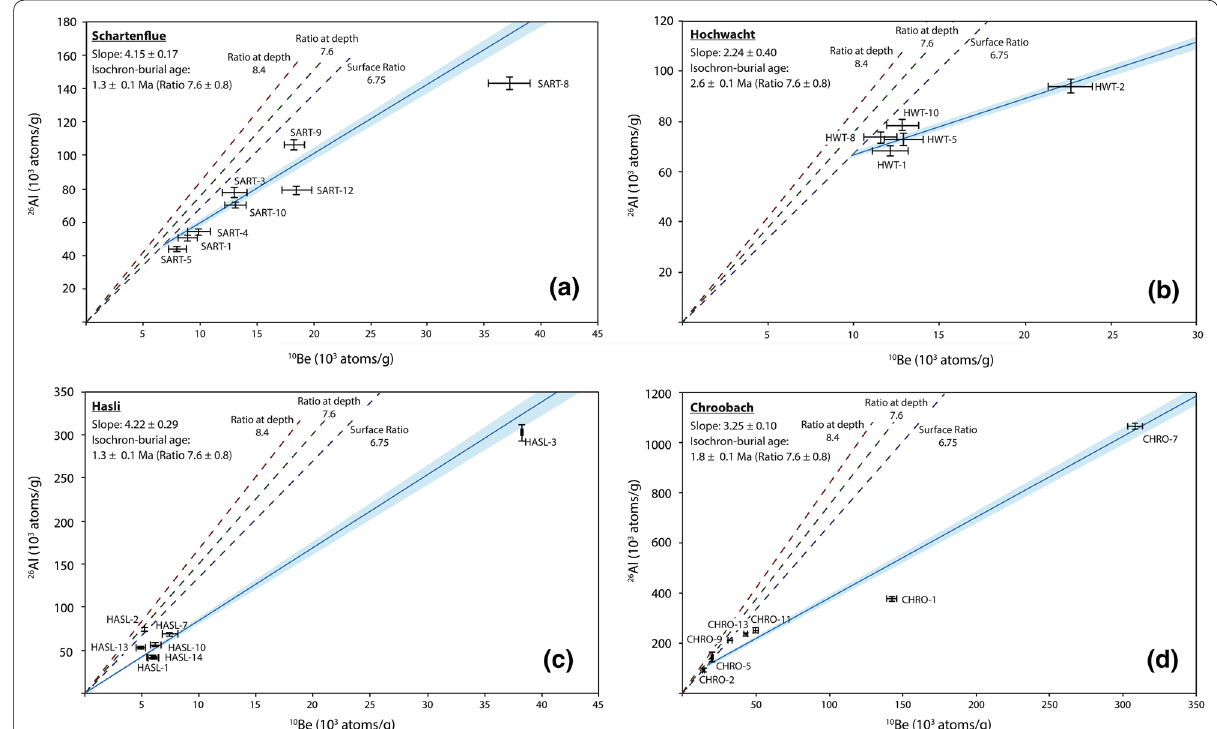
Fig. 14 Isochron plots of the samples from Schartenflue, Hochwacht, Hasli, and Chroobach with 1σ uncertainties and the isochron-burial age calculated with initial ratio of 7.6 0.8. The blue line shows the best-fit isochron line and the light blue envelope the 1σ solution ±